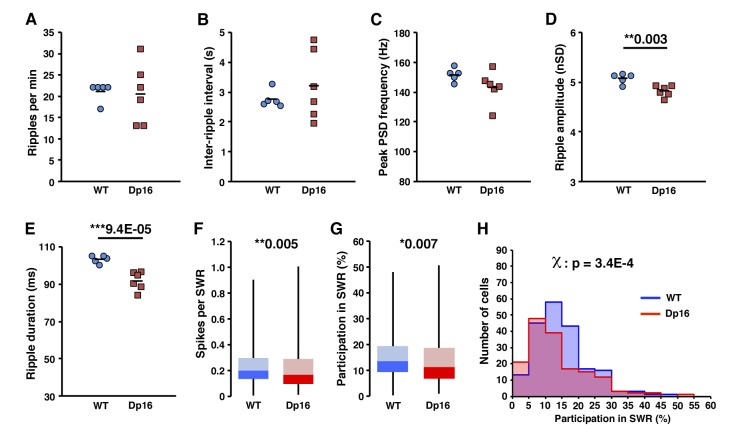
Decreased activity of CA1 pyramidal cells during ripple events in Dp(16)1Yey mice is not related to ripple detection bias.Onset and offset of ripple events were detected using the underlying multiunit activity in order to prevent a bias eventually caused by the amplitude of these events in Dp16 mice. The number of ripples per minute (A), inter-ripple interval (B) and peak power spectrum density frequency of ripple events were not significantly different between Dp16 and WT littermates. Their amplitude (D) and duration (E) were however significantly decreased in the Dp16 group. The number of spikes per ripple (F) and participation in ripple events (G) were significantly lower in Dp16 mice. (H) The proportion of cells plotted as a function of their participation rate in sharp-wave ripples showed a significant shift toward lower participation rates, with Dp(16)1Yey pyramidal cells peaking at 5–10% participation whereas the peak was at 10–15% in the WT group. Each marker in (A) thru (E) represents average value from all events in an individual mouse. Statistical significance was assessed using one-way ANOVA (A–E) or Mann-Whitney U-test (F, G) with significance set at (*) p<0.05 and (**) p<0.01 and (***) p<0.001.